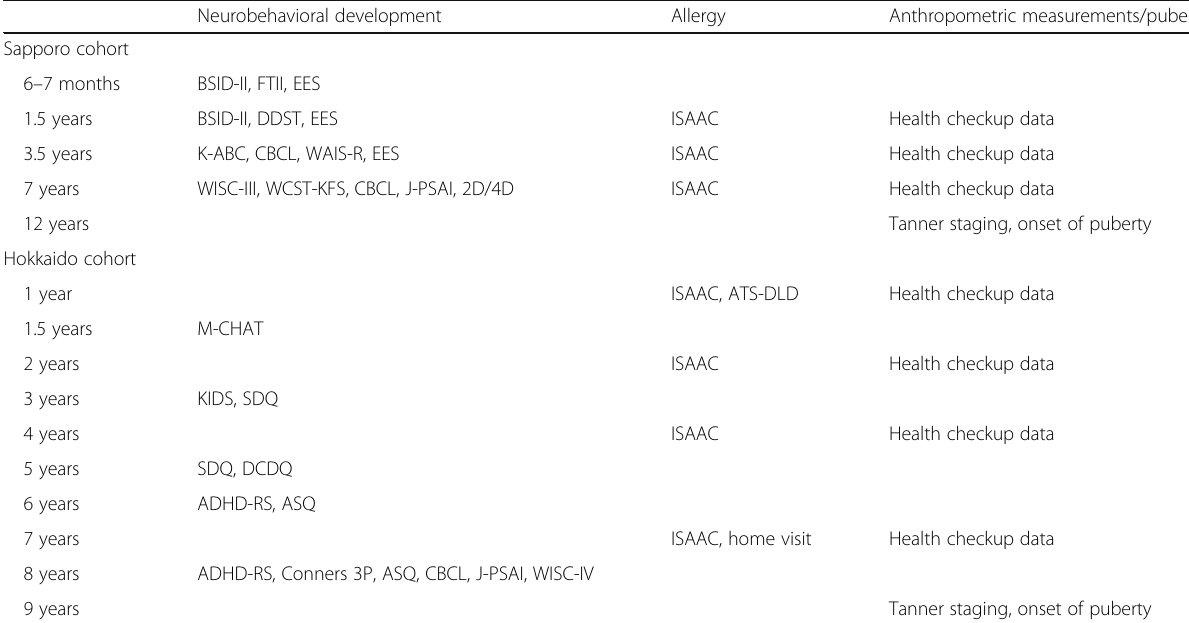
Table 1 Follow-ups performed at different ages Neurobehavioral development Allergy Anthropometric